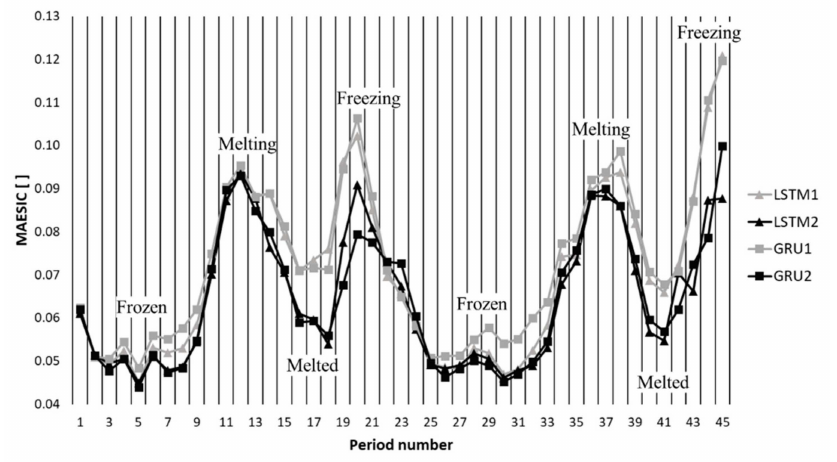
Figure 7. Mean absolute error in sea ice concentration (MAESIC) in the test periods.